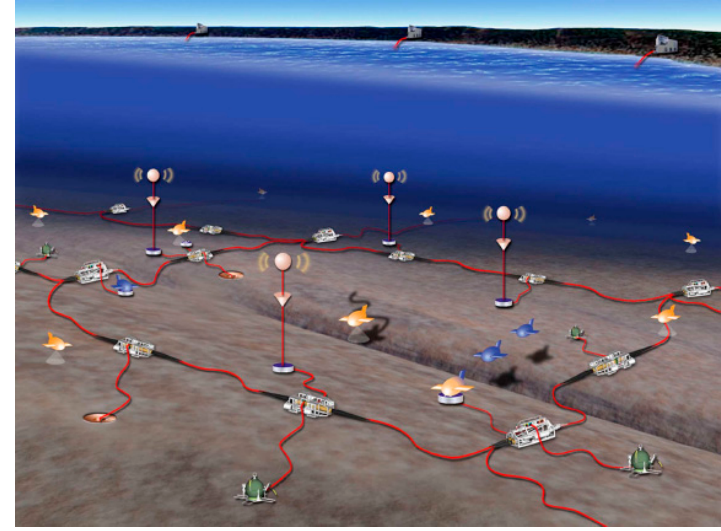
Figure 1. Schematic diagram of typical mesh topology CC remote power supply system.